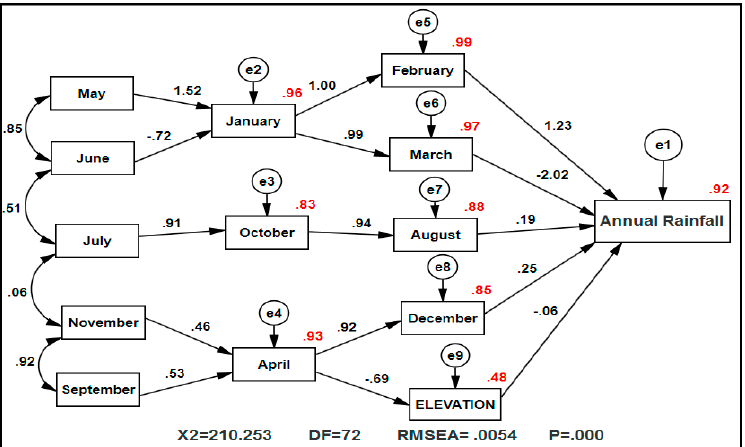
Figure 18. The effectiveness of the temperatures and elevation on annual rainfall (sixth model).